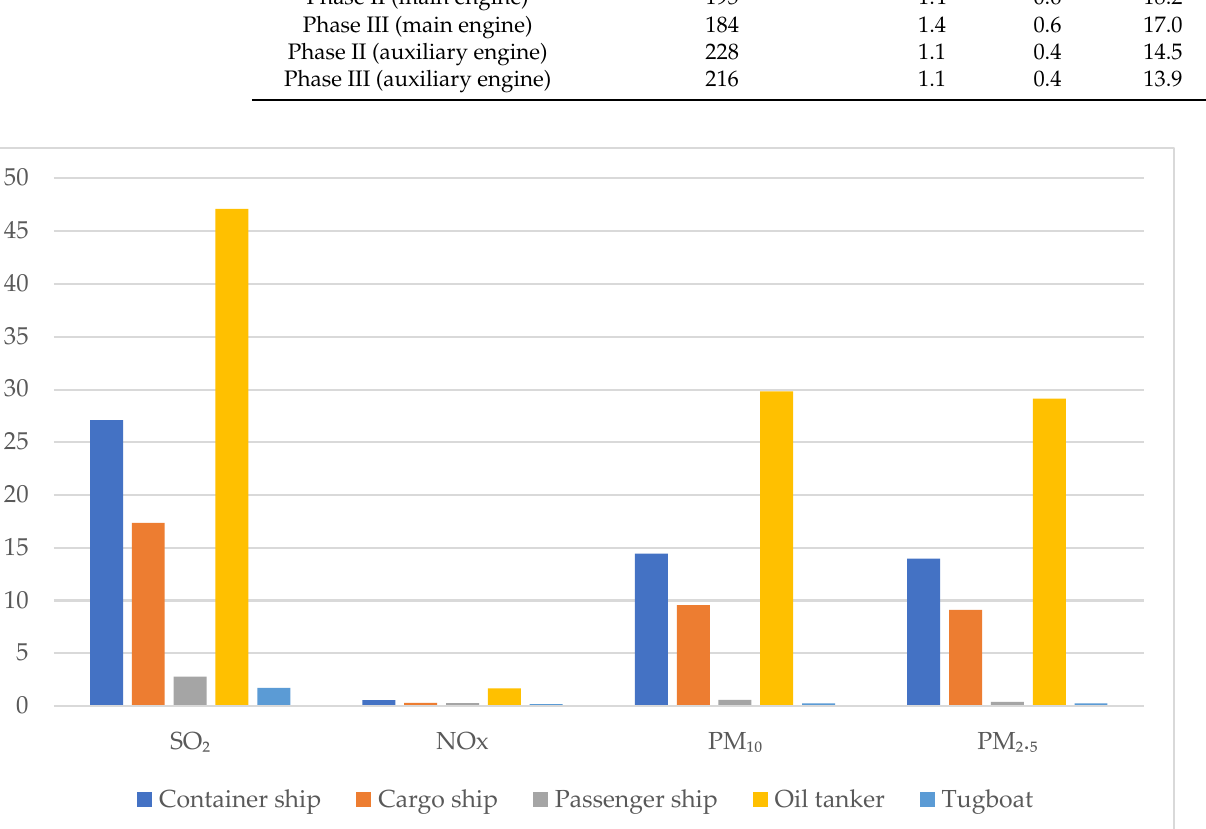
Figure 17. Changes in the proportion of ship pollutant emissions under different policies.